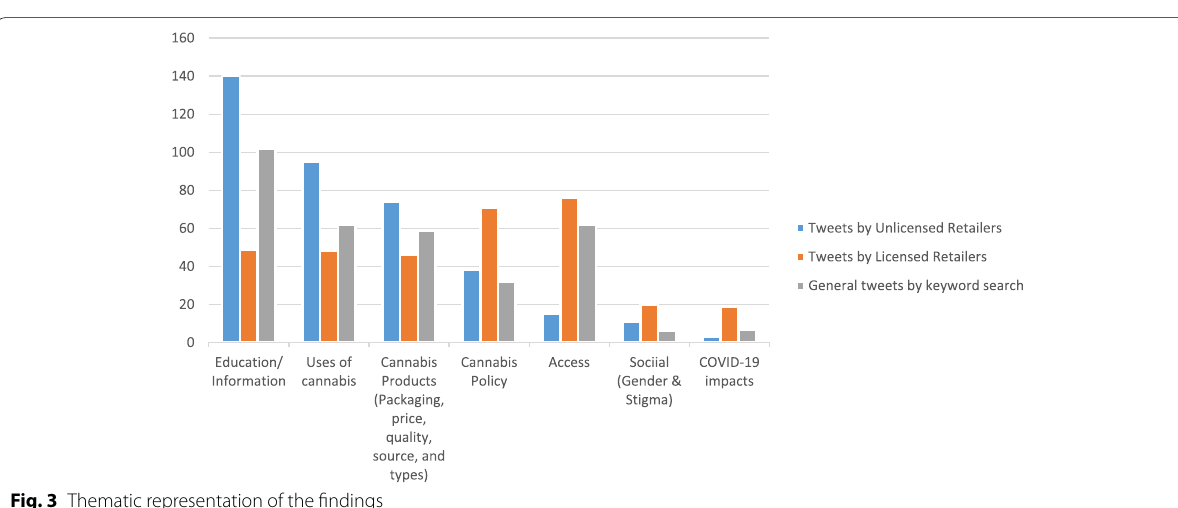
Fig. 2 Distribution of tweets selected for analysis